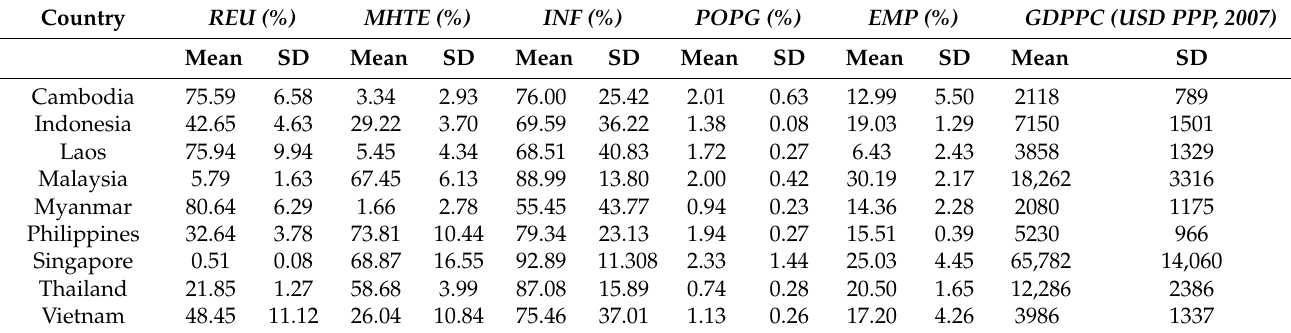
Table 1. Descriptive statistics of variables of each ASEAN country